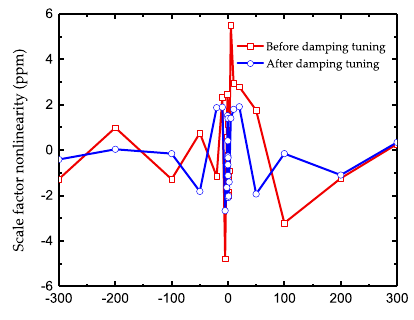
Figure 13. The scale factor nonlinearity of gyroscope before and after damping